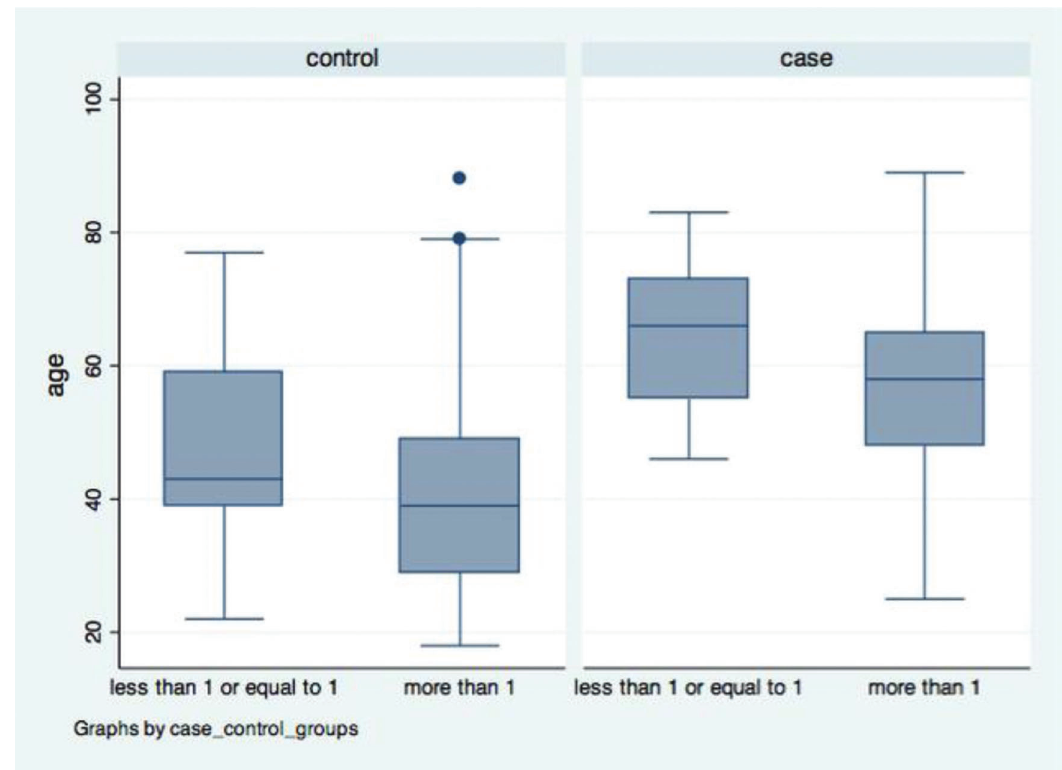
Figure 4 - Box Plots: age versus pelvic–trochanteric